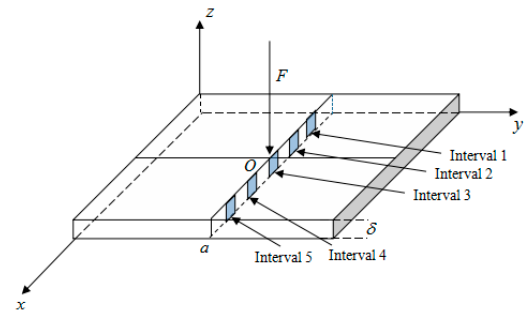
Figure 11. The interval selection diagram. Table 2. Error comparison between di ff erent models and experimental stress values (N/cm 2 ) ( λ = 18.75).